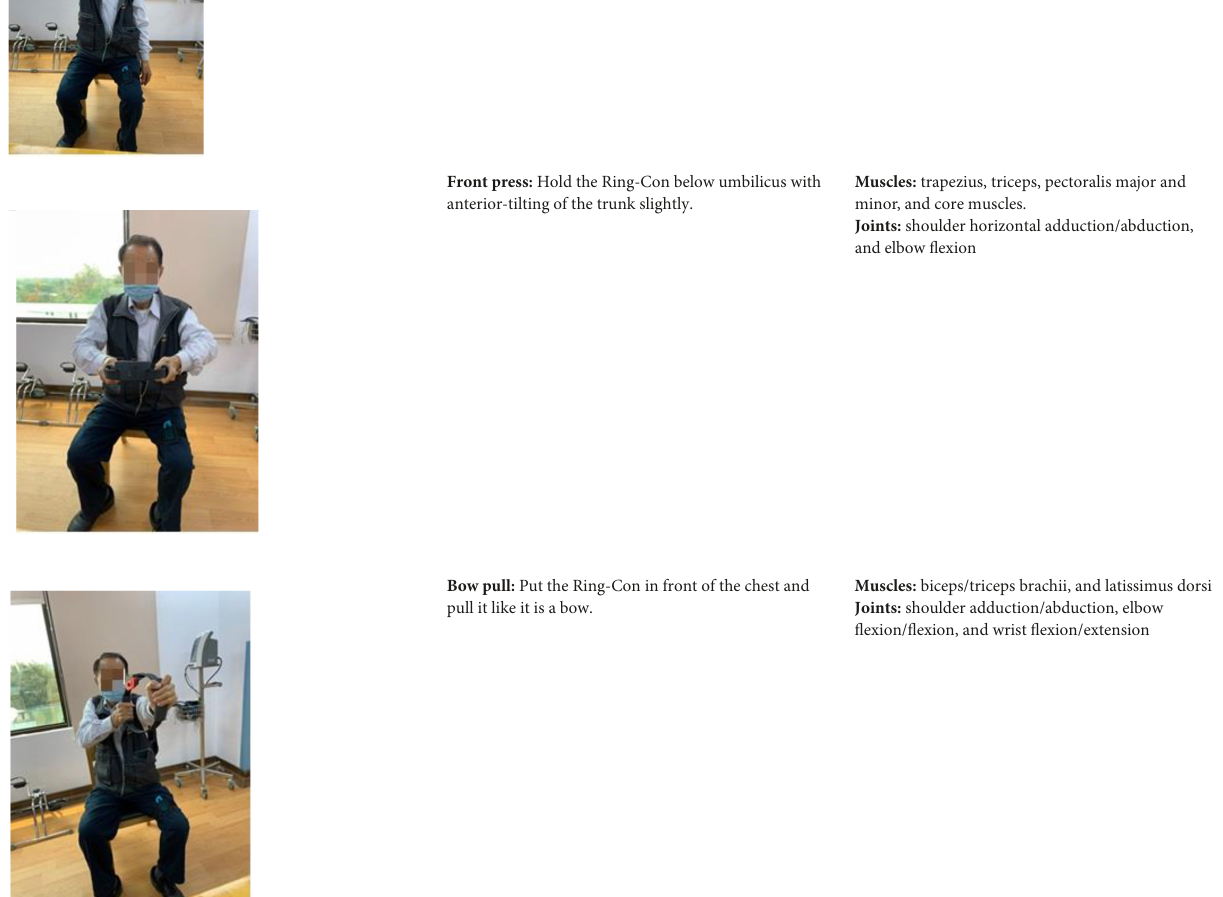
Shoulderpress: Hold the Ring-Con on each side of the shoulder and squeeze it.